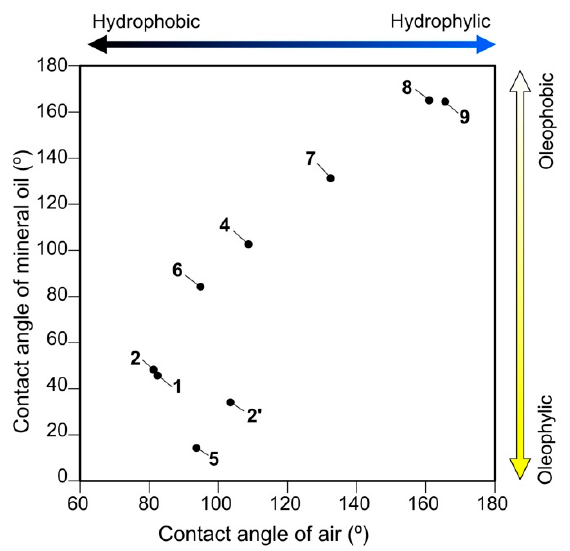
Figure 4. The rank of substrate preference in the settlement of Phallusia philippinensis larvae with water- and oil-wettability (modified from [11]). The numbers indicate the rank of preference with the rank of 2 and 2 ′ being tied. 1, polytetrafluoroethylene; 2, silicone rubber; 2 ′ , polyvinylidene chloride; 4, polychlorotrifluoroethylene; 5, Parafilm (Amcor Ltd.); 6, polyvinyl chloride; 7, glass; 8, 1.5% agar; 9, SH2CLHF (SH: 3M).